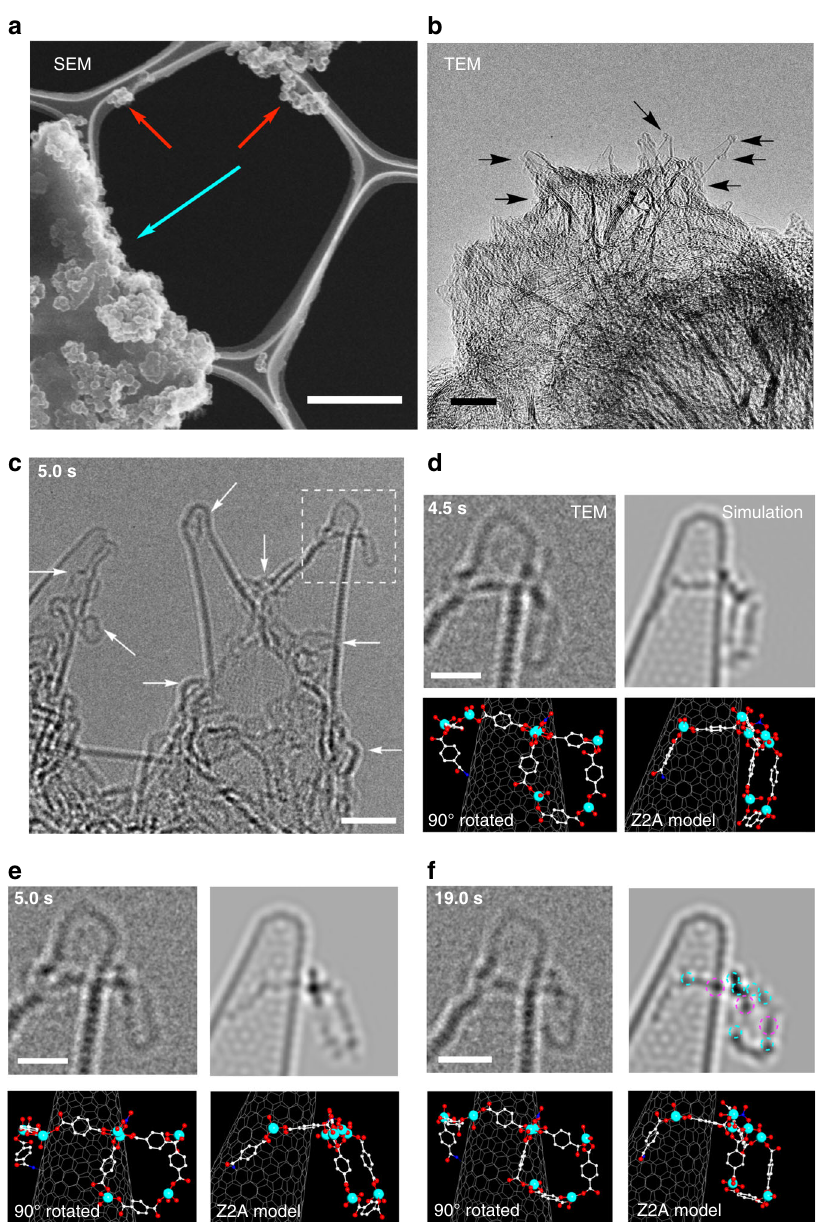
Fig. 3 Electron microscopic imaging of PNCs in MOF-2 and MOF-5 syntheses at 0.01 M of Zn 2 + for 21 h. a SEM image of a MOF-5 crystal (blue arrow) and agglomerates of BDC-CNH particles (red arrows) in a sample dry transferred to a TEM microgrid. The scale bar is 1 μ m. b TEM image of a BDC-CNH particle trapping PNCs (arrows) of I-MOF-5 (dry transfer). The scale bar is 10 nm. c Numerous 1-D and 2-D PNCs (arrows) of MOF-2 on BDC-CNH (methanol wash). The scale bar is 2 nm. d – f A TEM video frame, TEM simulation, and Z2A model of the 2-D PNC of the boxed area in c taken at various times after starting the video recording (the same for time stamps of all video frames below): d 4.5 s, e 5.0 s, and f 19.0 s. Colour coding: O, red; Zn, light blue; N, blue; C, grey (the same colour codes for all models below). See Supplementary Fig. 3 for details. The original video is in Supplementary Movie 1. The scale bar is 1 nm. Positions of zinc atoms (light blue) and benzene rings parallel to the electron beam (purple) are circled in